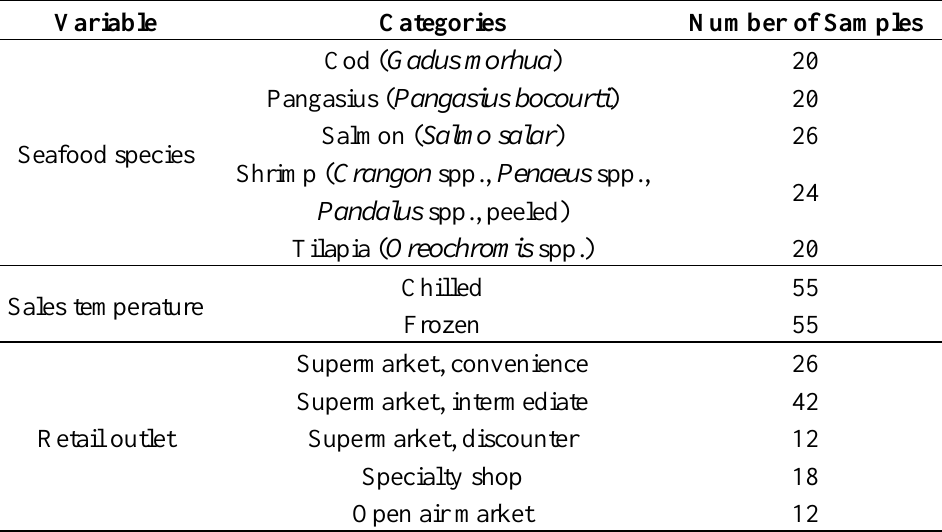
Table 1. Sampling